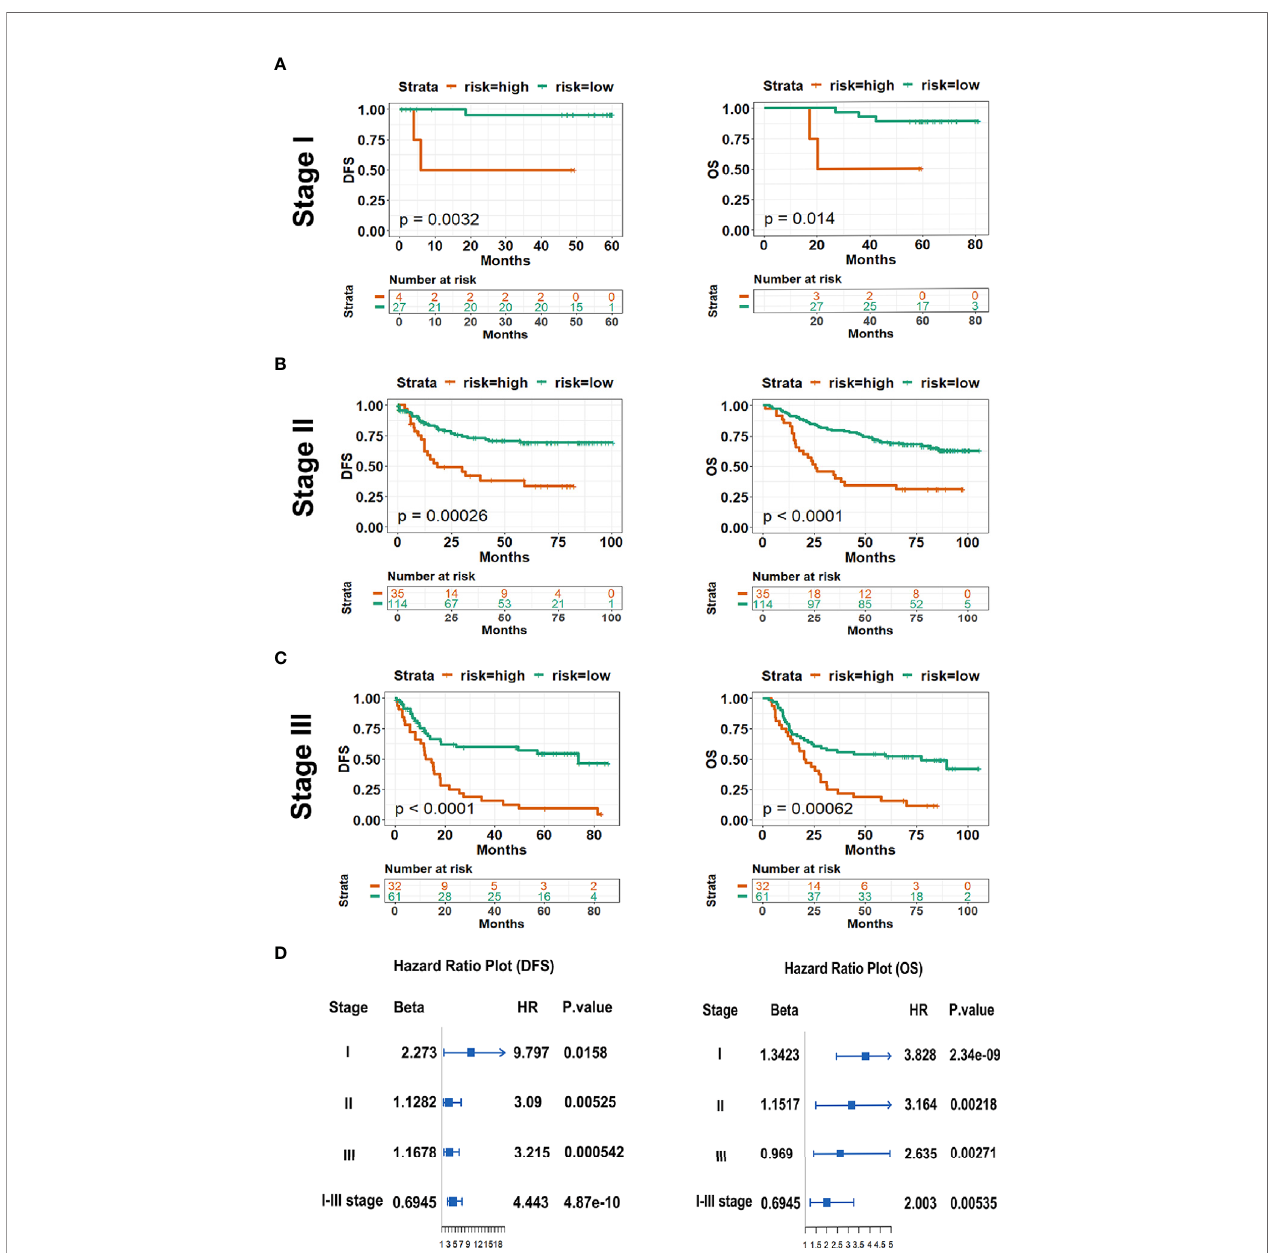
FIGURE 4 | Kaplan-Meier survival analysis of DFS (left pane) and OS (right pane) according to IS in subgroups of patients with GC in the training cohort. (A) Stage I ( n = 30); (B) Stage II ( n = 97); (C) Stage III ( n = 146); (D) The survival impact of IS in TNM stage subgroup. HR , hazard ratio; IS , immunoscore; DFS , disease free survival; OS , overall